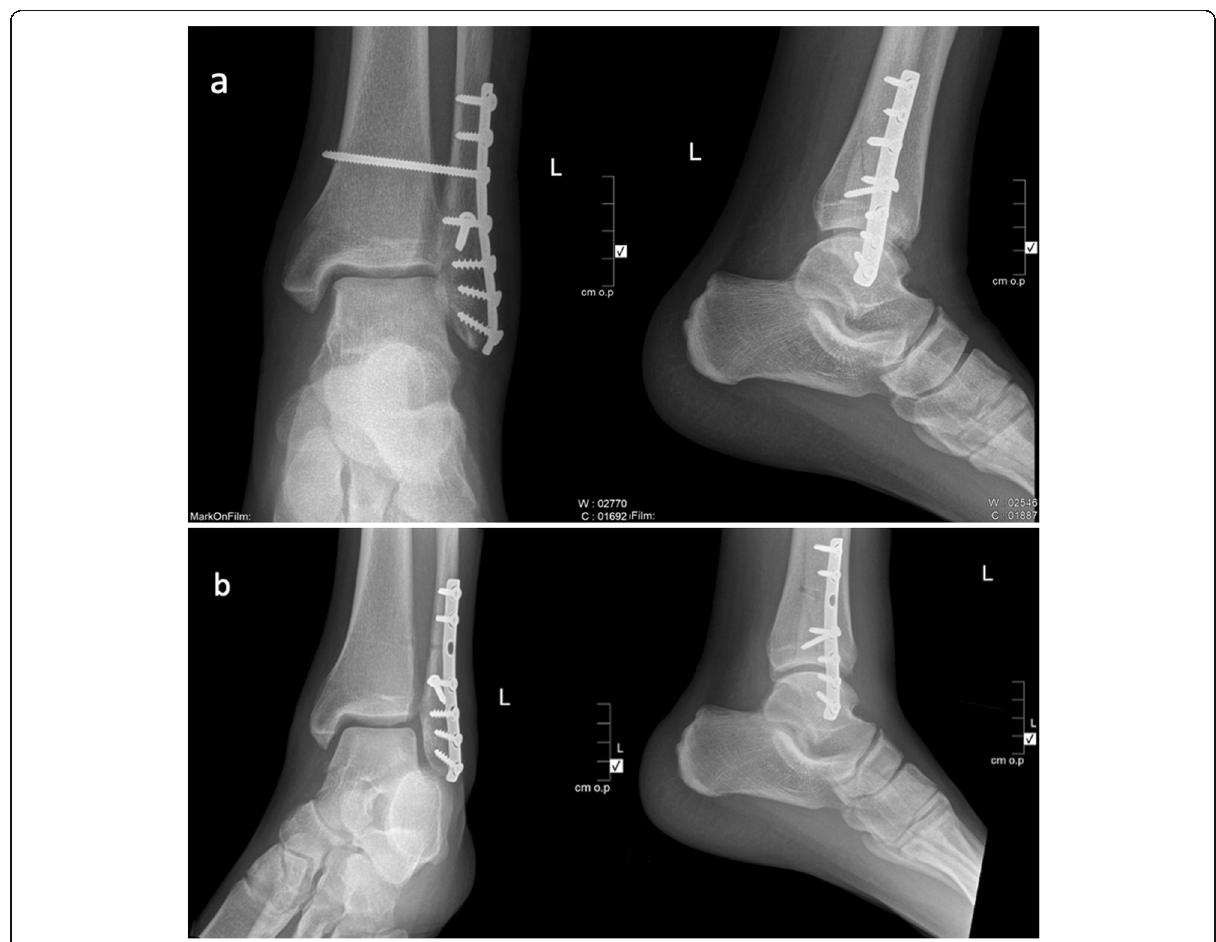
Fig. 4 Example of recurrent diastasis after removal of syndesmotic screws. a Post-operative anteroposterior and lateral plain ankle radiographs demonstrating lateral malleolus neutralizing plate and syndesmotic screw fixation. b Post-operative anteroposterior and lateral plain ankle radiographs showing recurrent tibio-fibular diastasis after removal of the syndesmotic